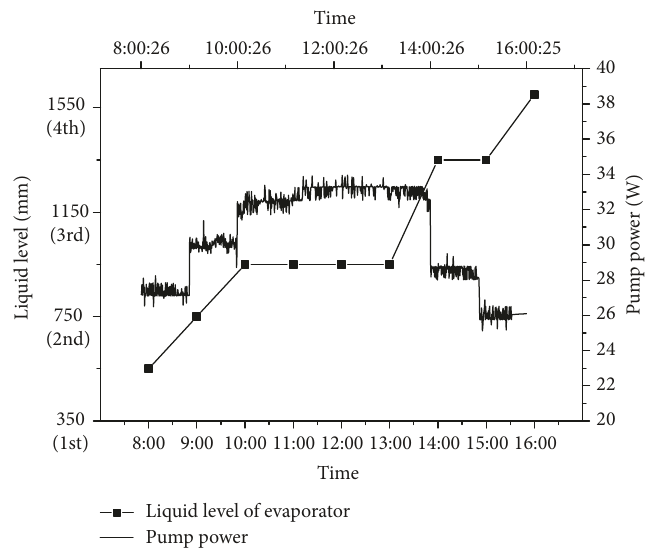
Figure 5: Qualitative variation of the liquid level of the evaporator and pump power.